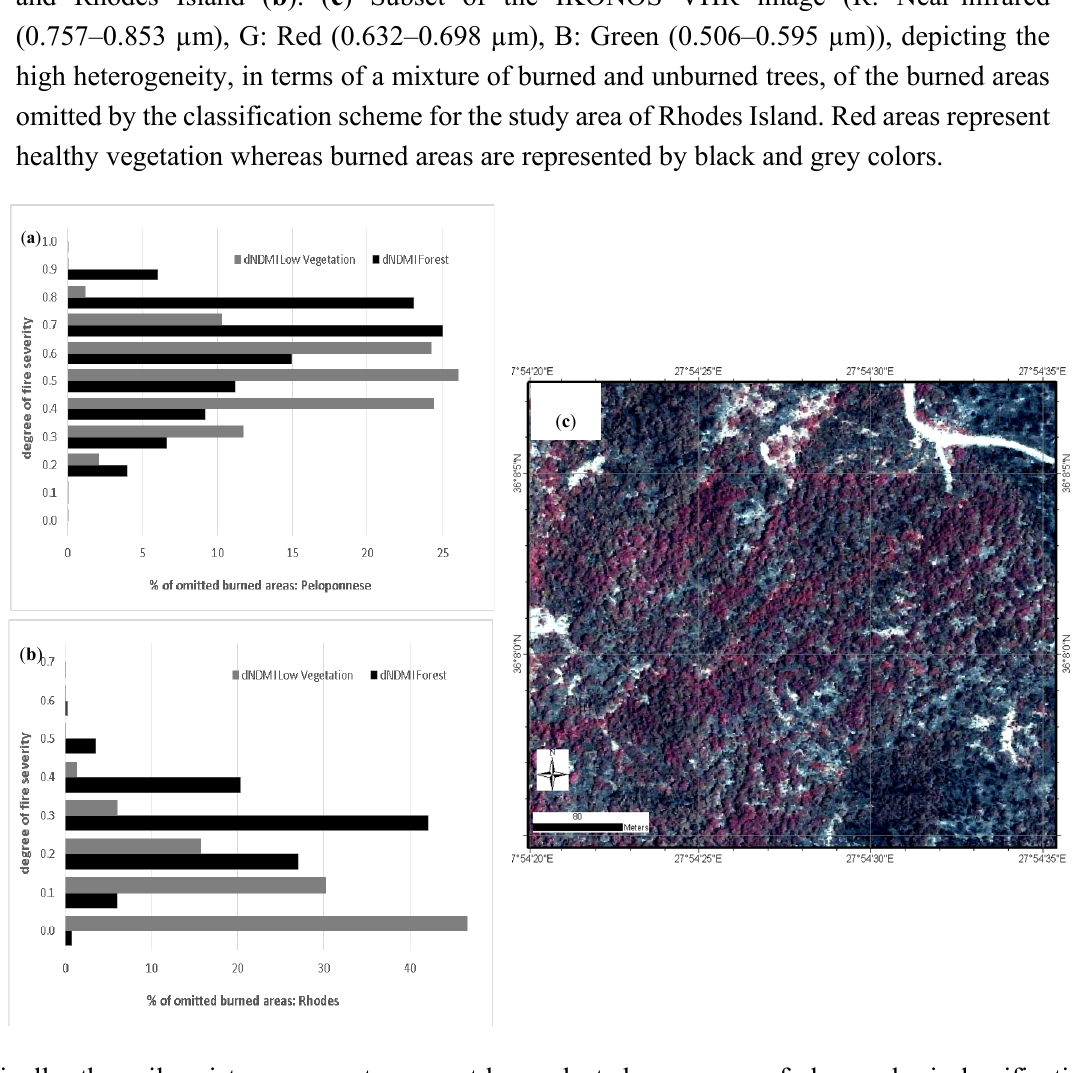
) for the two study f